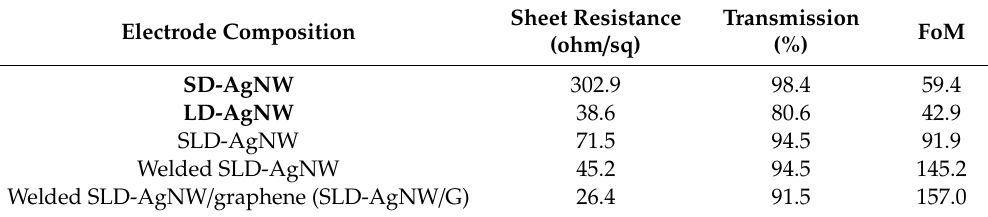
Table 1. The sheet resistance, transmission, and figure of merit (FoM) of di ff erent electrodes.